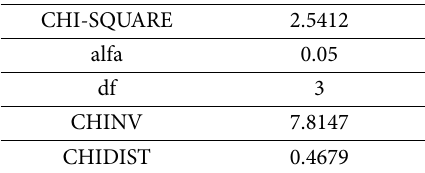
Table 4. Verification of the hypothesis H2 0